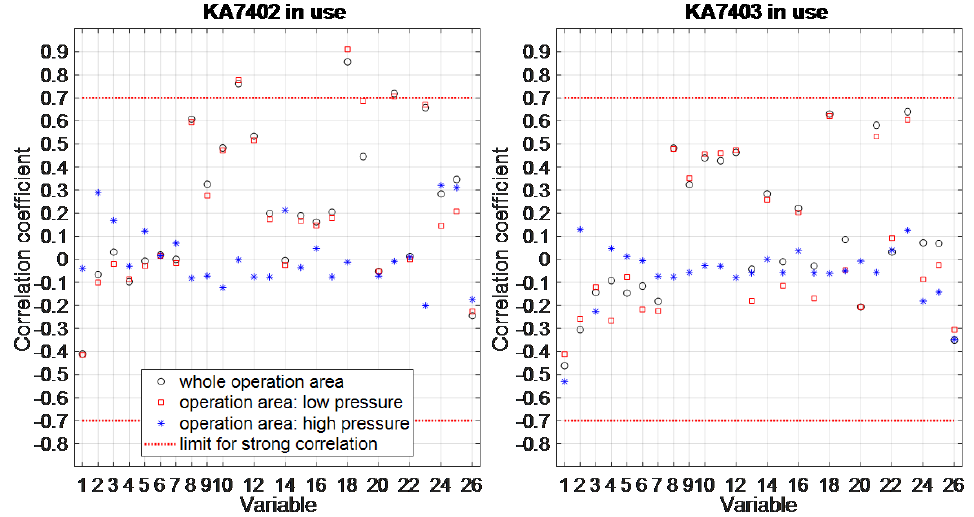
Figure 3: Correlation coeflcients in different operation areas